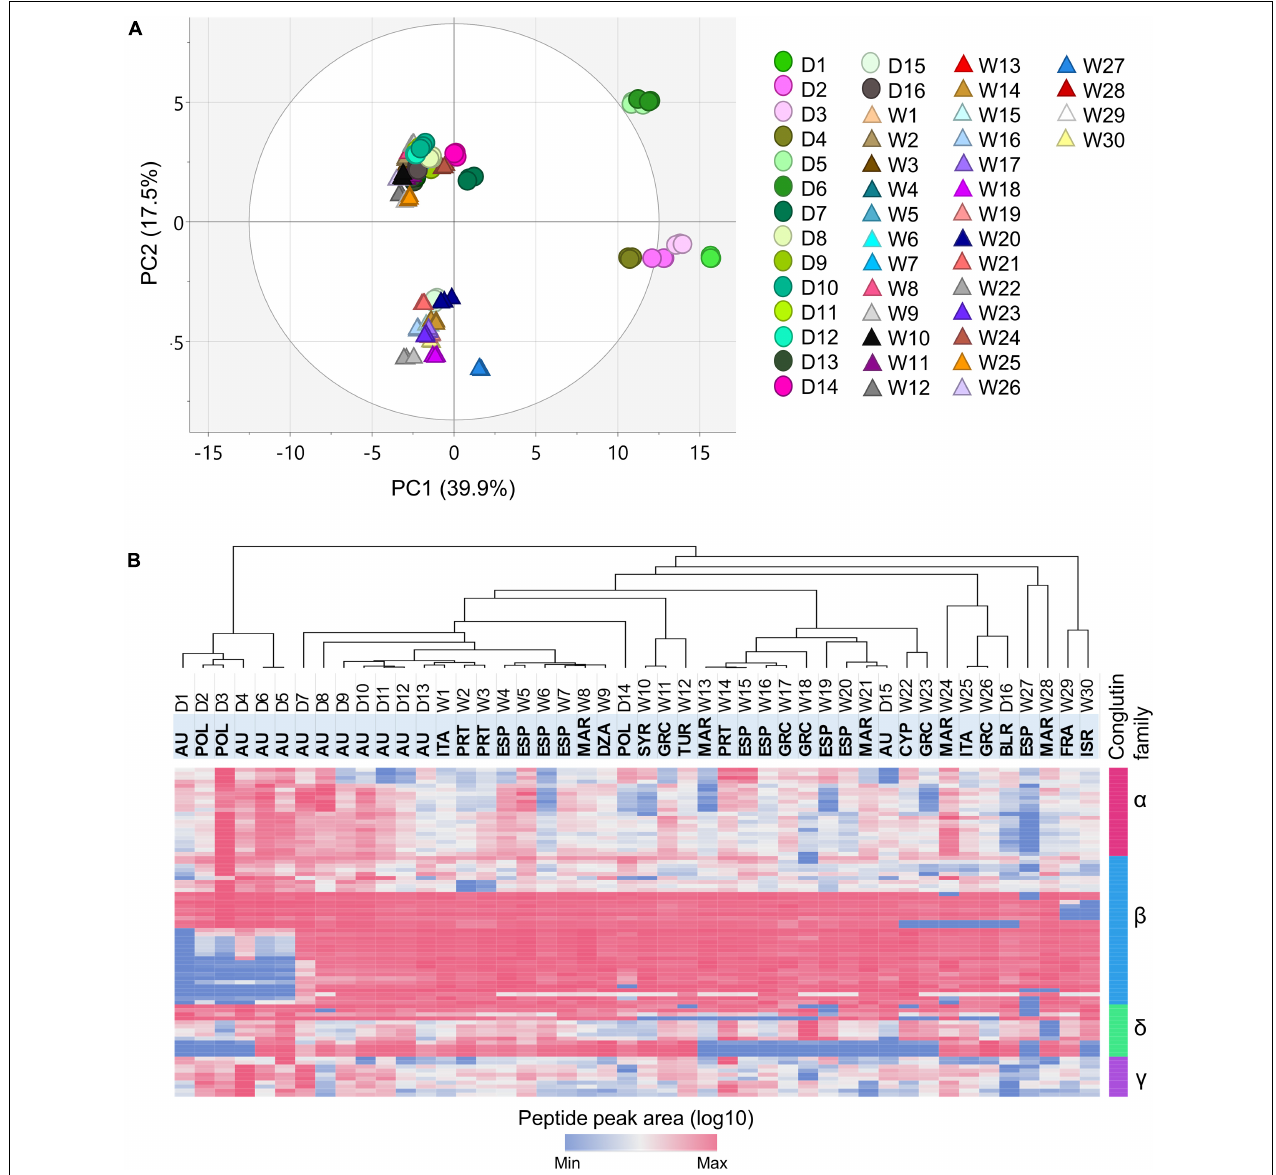
FIGURE 2 | Multivariate analysis of the peptide level abundance data. (A) The PCA scores plot, PC1 vs. PC2, showing the separation of 46 NLL genotypes based on the conglutin-derived peptide data (log10). Each color represents an NLL genotype where the wild (triangles) and domesticated (circles) varieties are indicated. (B) The heatmap displaying the monitored marker peptide peak areas (log10) across the analyzed lines. The dendrogram from the unsupervised HCA illustrating the similarity of the NLL varieties in terms of conglutin abundance. Each column corresponds to a genotype and every row represents a peptide. The highlighted row at the top illustrates the counties of origin for the lines under study. The country names are abbreviated as follows: DZA (Algeria), AU (Australia), BLR (Belarus), CYP (Cyprus), FRA (France), GRC (Greece), ISR (Israel), ITA (Italy), MAR (Morocco), POL (Poland), PRT (Portugal), ESP (Spain), Syria (SYR), and TUR